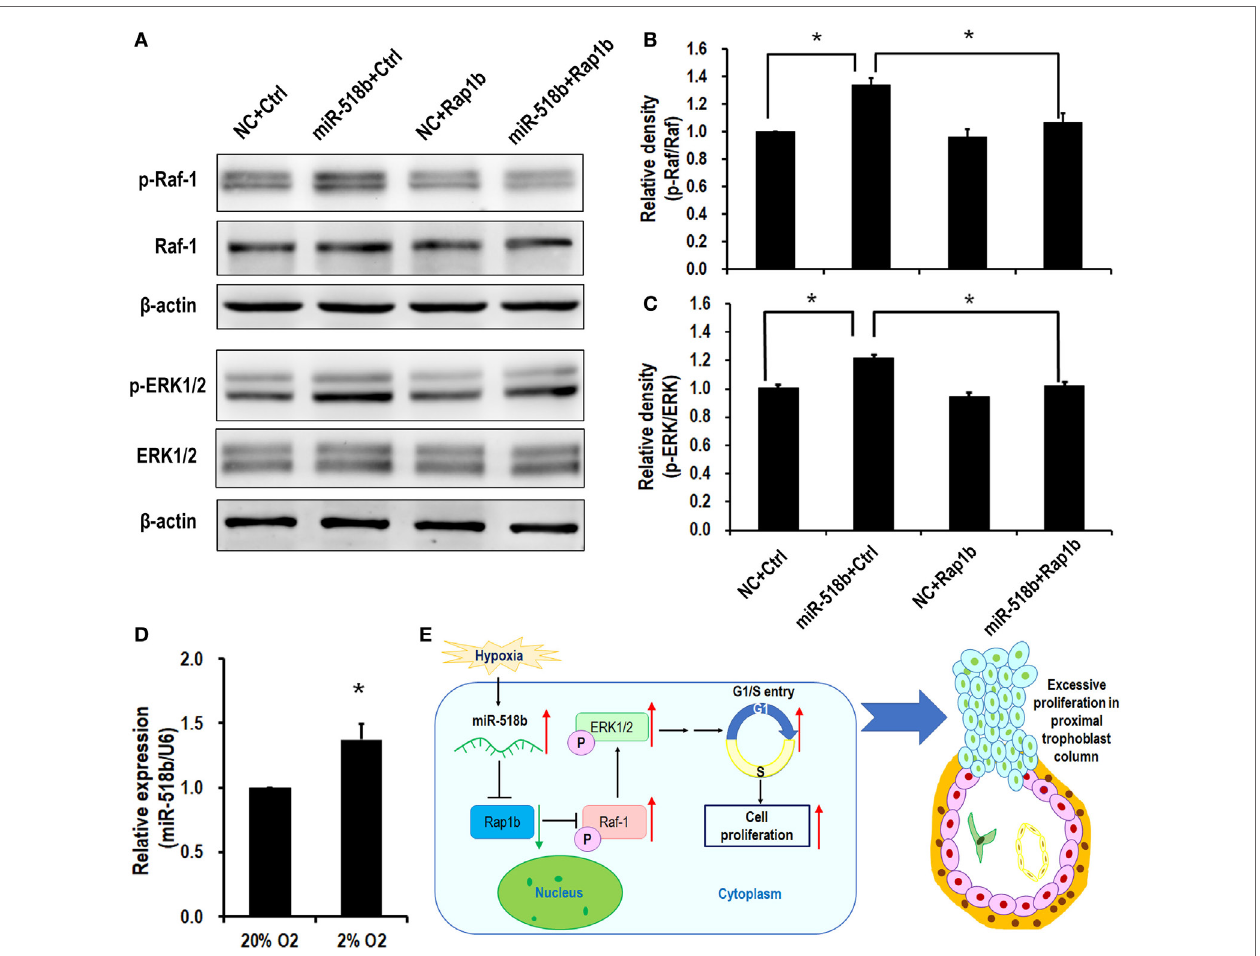
FigUre 5 | RAS and MAPK are the downstream pathways of miR-518b and Rap1b. (a–c) Western blotting to measure the phosphorylation level of Raf-1 and ERK1/2 after transfected with miR-518b or scramble negative control (NC) and Rap1b-encoding plasmid (Rap1b) or control plasmid (Ctrl). (b,c) represent the statistical results of p-Raf-1 and p-ERK1/2 shown in (a) . (D) Change in miR-518b upon hypoxia condition (2% O 2 ). Each of the tests was replicated for three times. Data are presented as mean ± SEM. * P < 0.05. (e) Schematic diagram of miR-518b and Rap1b in trophoblast cell proliferation. miR-518b targets Rap1b, and enhances trophoblast cell proliferation via Rap1b–Ras–MAPK pathway. Elevated expression of miR-518b leads to excessive proliferation in proximal column trophoblast cells, indicating that miR-518b may be involved in the etiology of